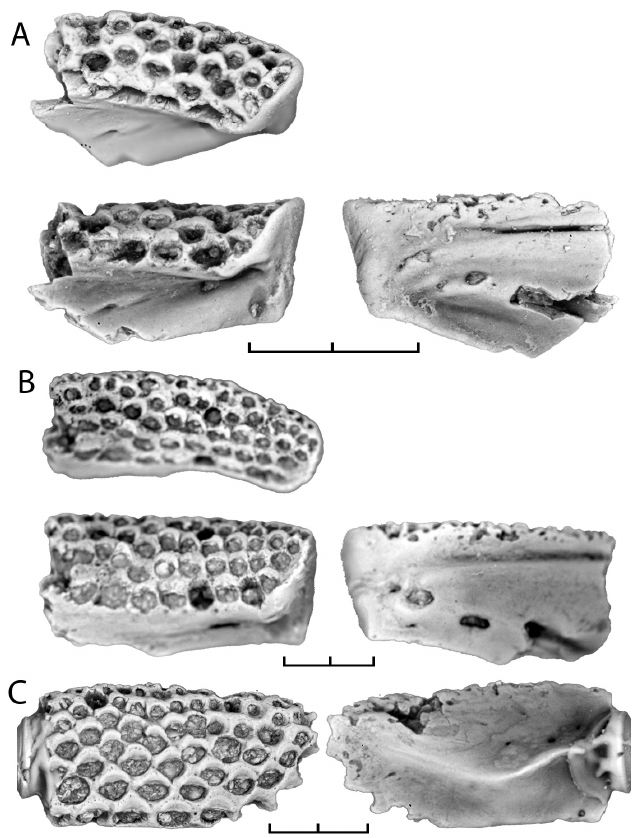
Figure 16. Jaw elements of the presumed ostariophysan designated Teleost U-3/BvD, from the Milk River